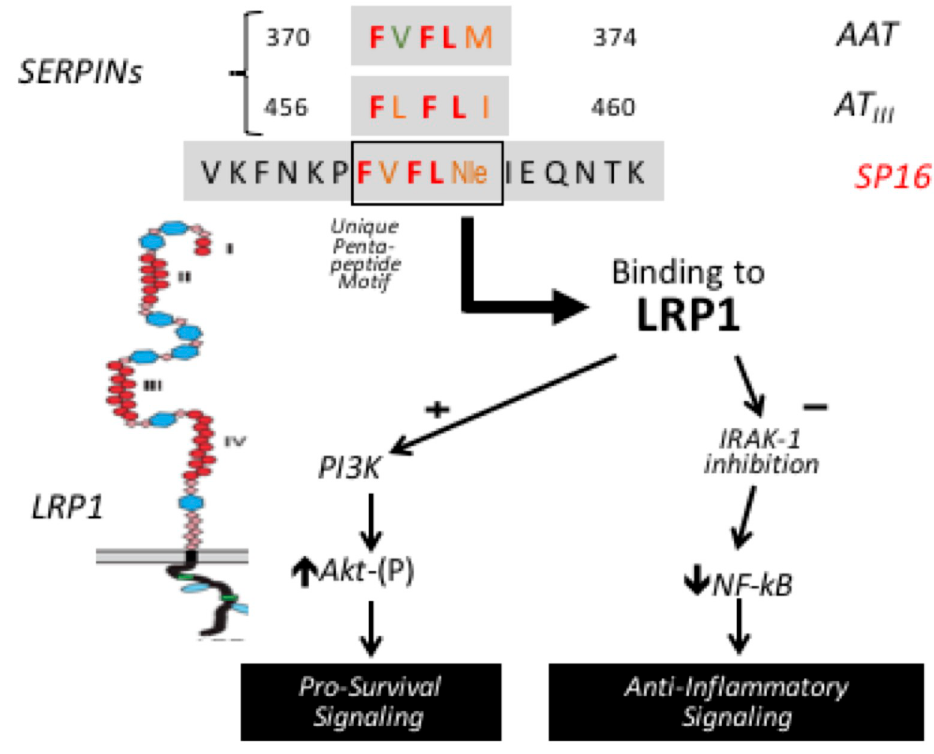
Fig 1. SP16, a novel, synthetic LRP1